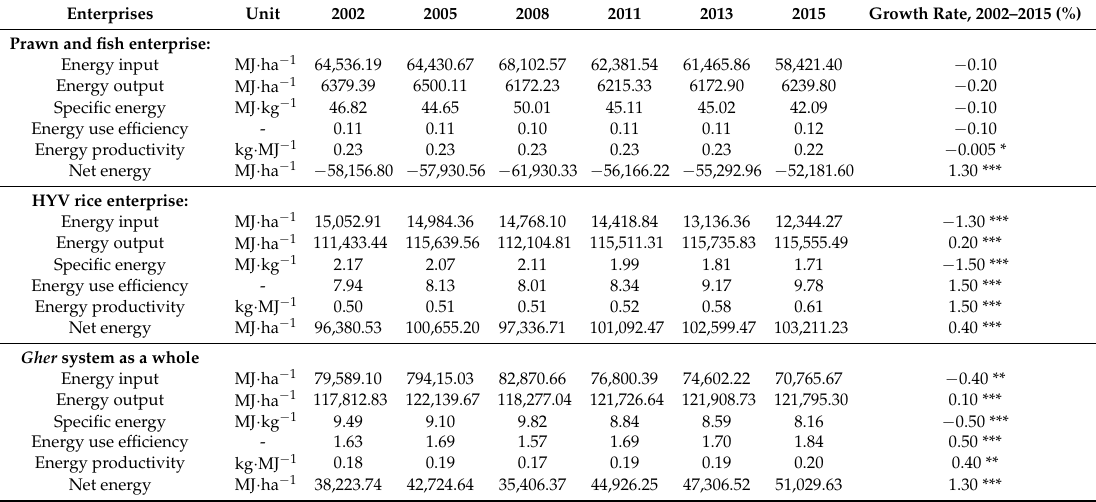
Table 3. Energy performance of the gher farming system over time (mean values for selected year).